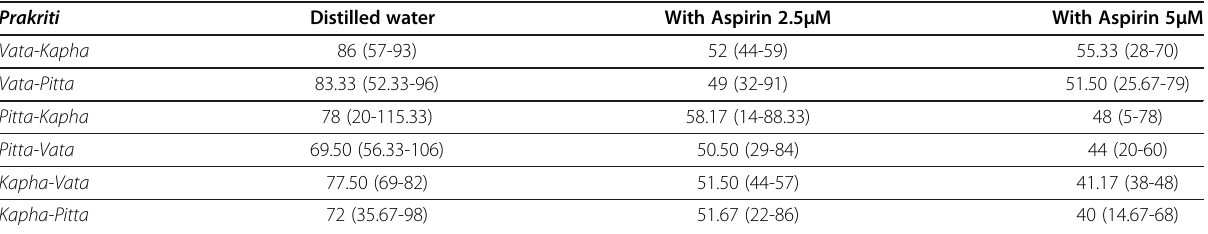
Table 2 ADP (5 μ M) induced % Maximal platelet aggregation (%MPA) (n=137) with or without aspirin [Median (Range)] Prakriti Distilled